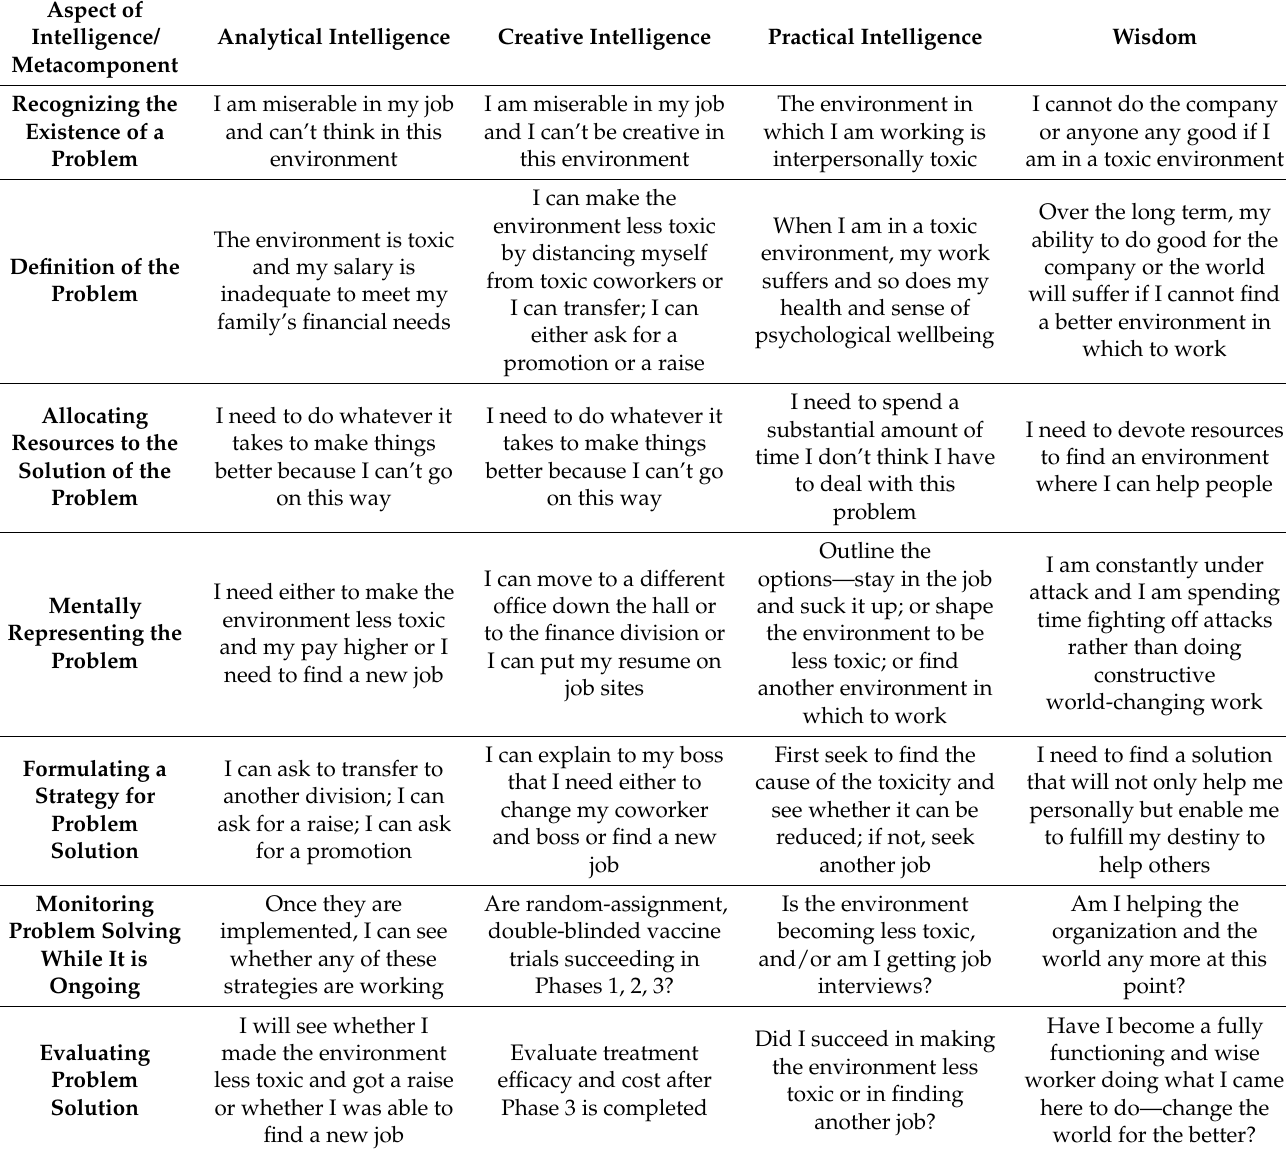
Table 1. Metacomponents Applied to Analytical, Creative, and Practical Intelligence, as well as